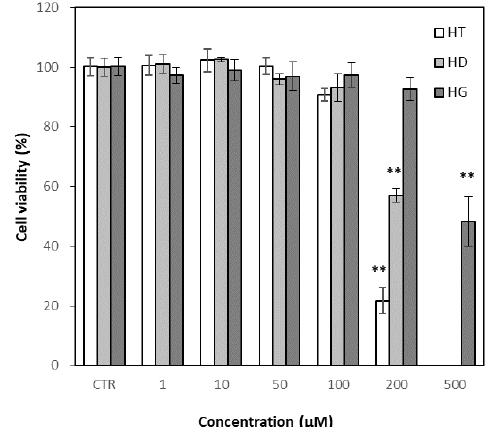
Figure 6. Effect of hesperetin, hesperidin and hesperidin glucoside on RAW 264.7 cell viability. Cells were treated with hesperetin, hesperidin and hesperidin glucoside, respectively, for 1 h and incubated for 24 h with LPS (final concentration of 1 μg/mL. Results were represented as mean ± SD ( n = 3). Significant differences from the control (** p < 0.01). CTR; Control (with LPS), HT; hesperetin, HD; hesperidin, HG; hesperidin glucoside.